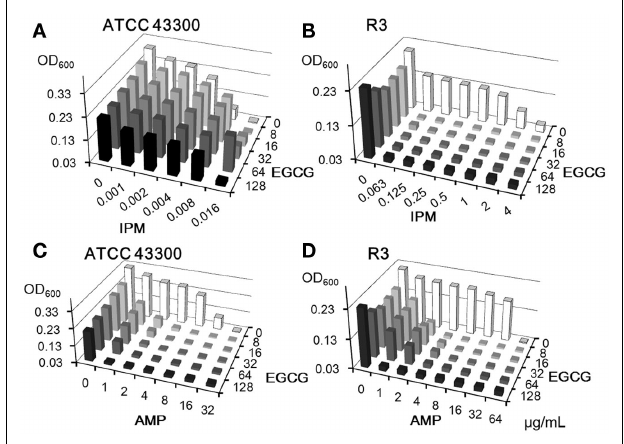
FIGURE 5 | Combinatorial effects of EGCG with IPM (A,B) orAMP (C,D) against MRSA strains. Optical densities (600nm) after 18h incubation were determined by the checkerboard method.